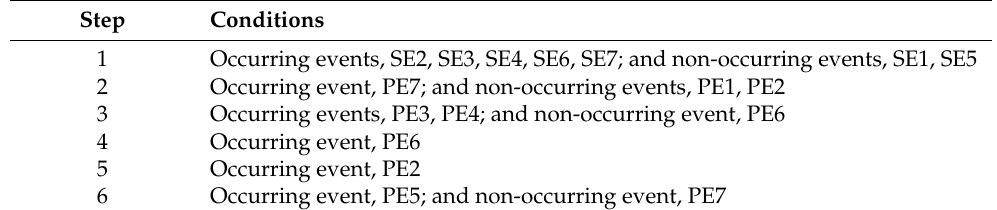
Table 15. Condition setting of scenario deduction for the Nanjing COVID-19